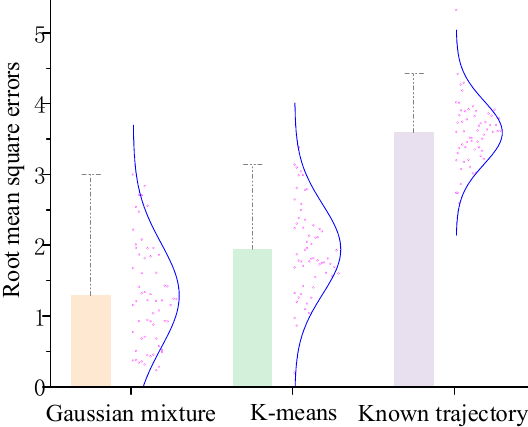
Figure 5. Root mean square errors of traffic demands with different observed data.